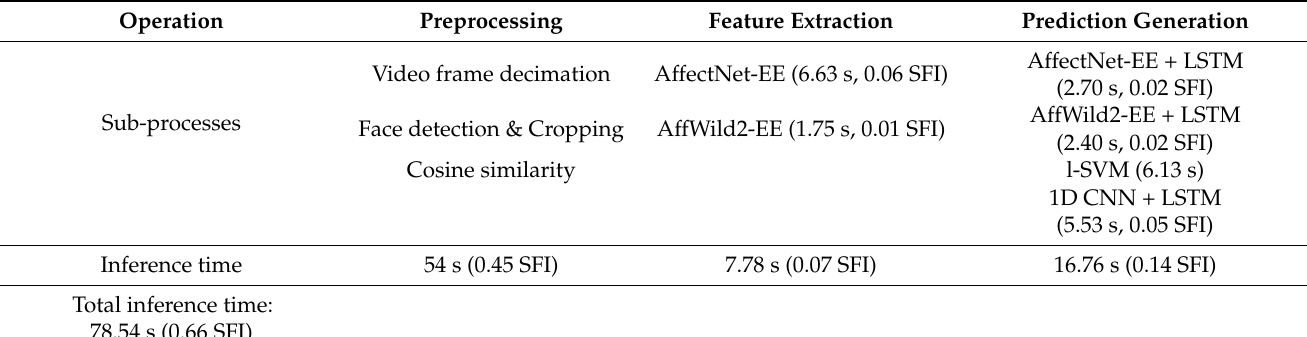
Table 9. The inference time for different sub-processes of the final fusion system. For the system’s testing, the video file “134.avi” with a duration of 119 s was chosen. SFI means “Seconds For Inference”, denoting the seconds needed to process one second of